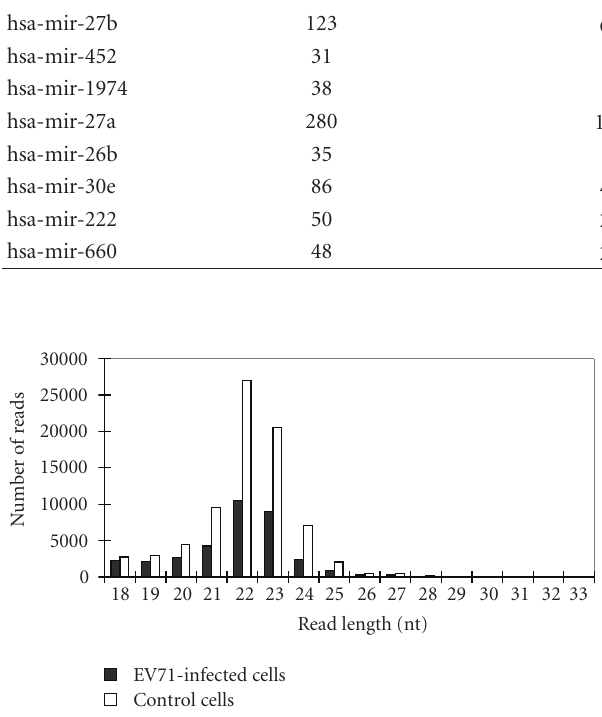
Figure 1: Size distribution of sequenced short